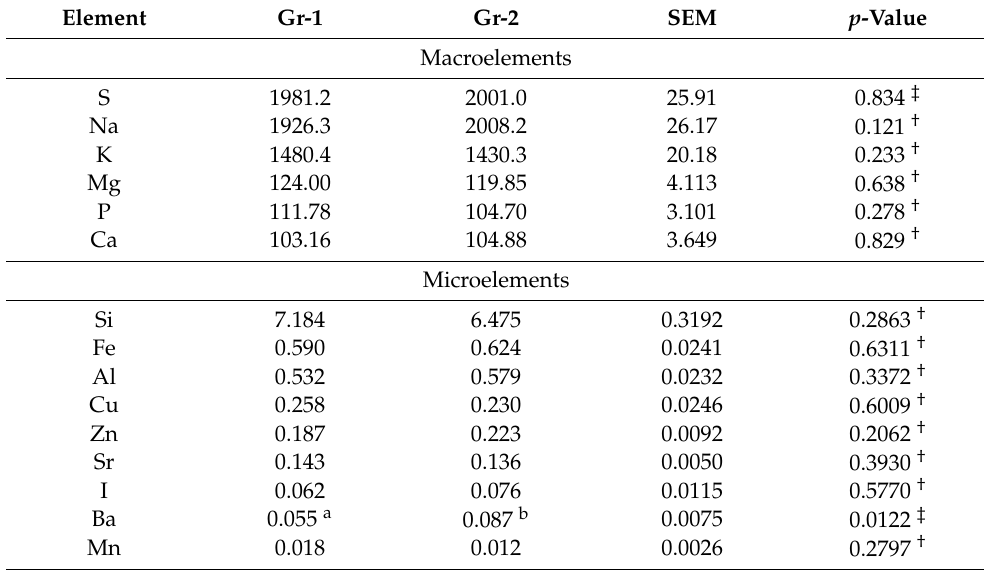
Table 5. The concentrations of macro- and microelements in the egg albumen (mg/kg). Element